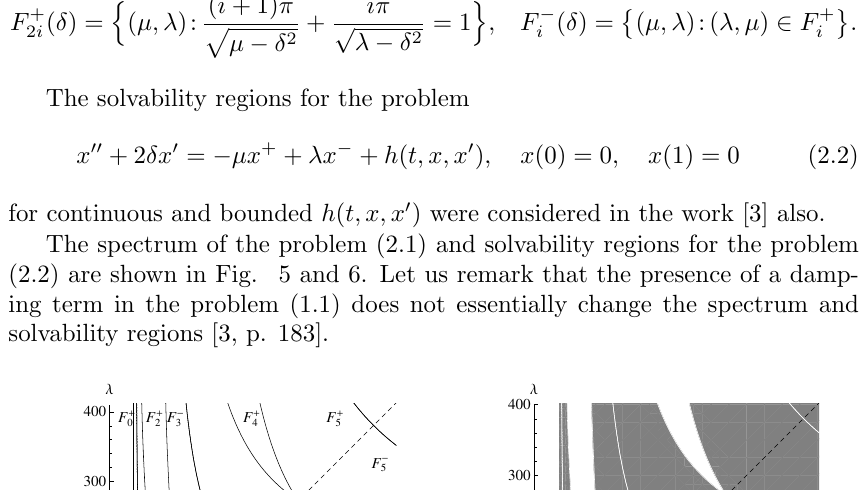
Figure 5. The spectrum of the problem (2.1) for δ = 5.